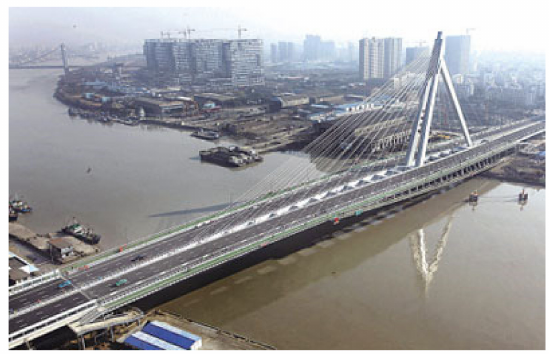
Figure 12. The case